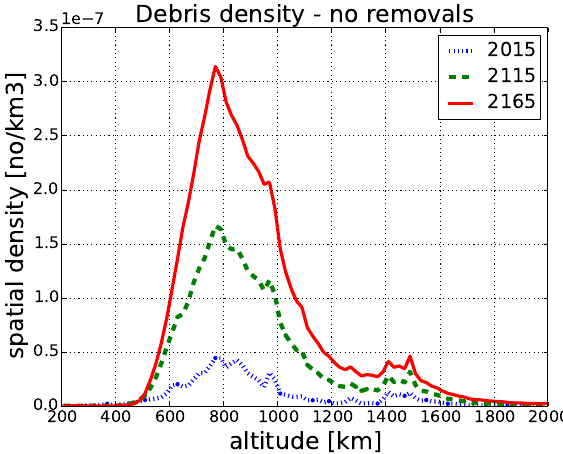
Figure 2. Spatial density prediction in Low Earth Orbit